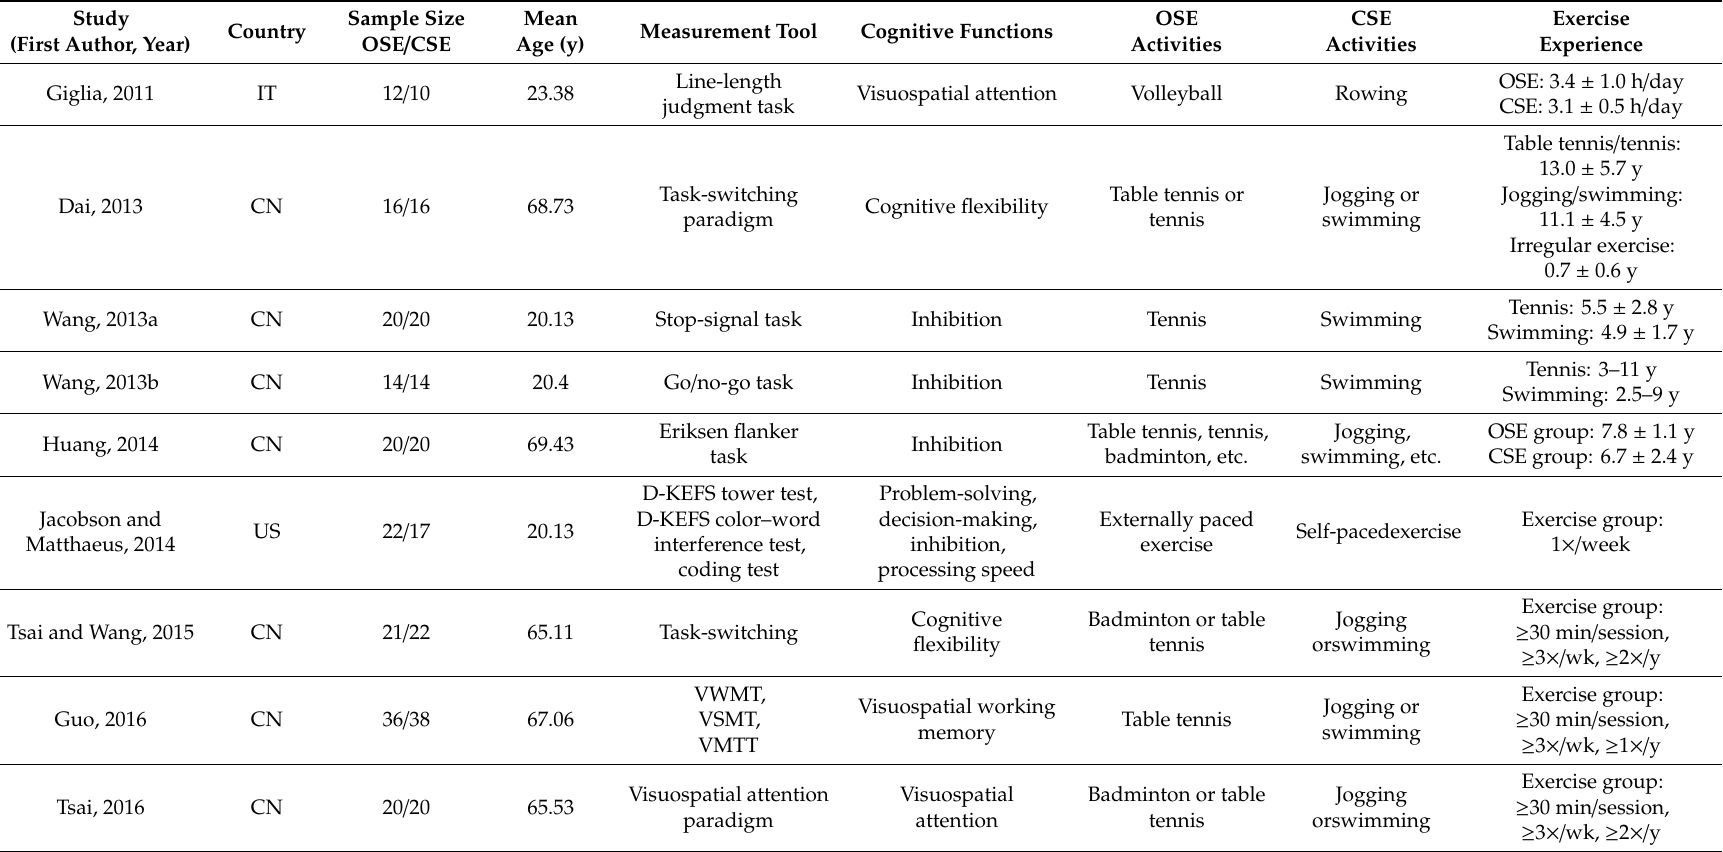
Table 1. Characteristics of the cross-sectional studies that were